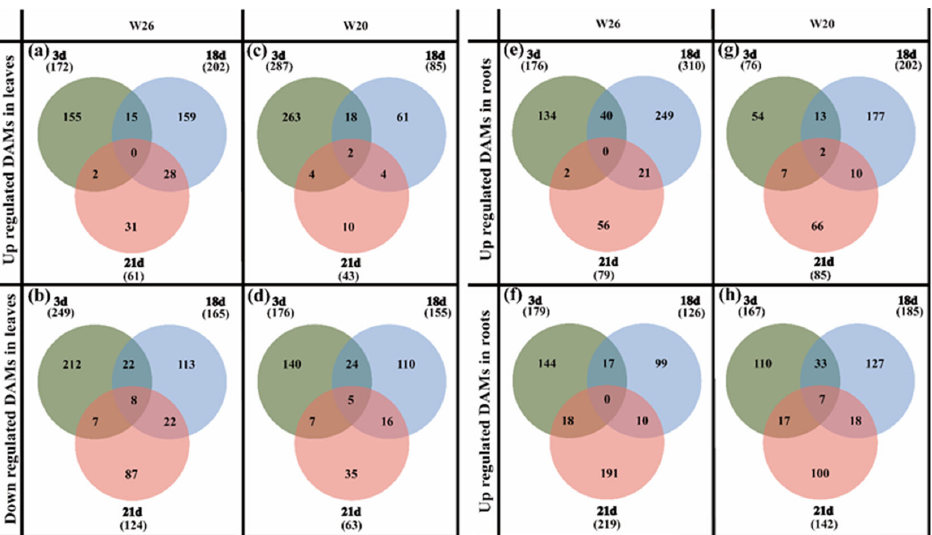
Figure 6. Venn diagram of DAMs W26 and W20 at different time points. ( a , b ) show the number of up ‐ regulated differential metabolites (DAMs) and down ‐ regulated DAMs in W26 leaves, respectively. ( c , d ) show the number of up ‐ regulated DAMs and down ‐ regulated DEGs in W20 leaves, respectively. ( e , f ) show the number of up ‐ regulated DAMs and down ‐ regulated DAMs in W26 roots, respectively. ( g , h ) show the number of up ‐ regulated DEGs and down ‐ regulated DAMs in W20 roots, respectively.